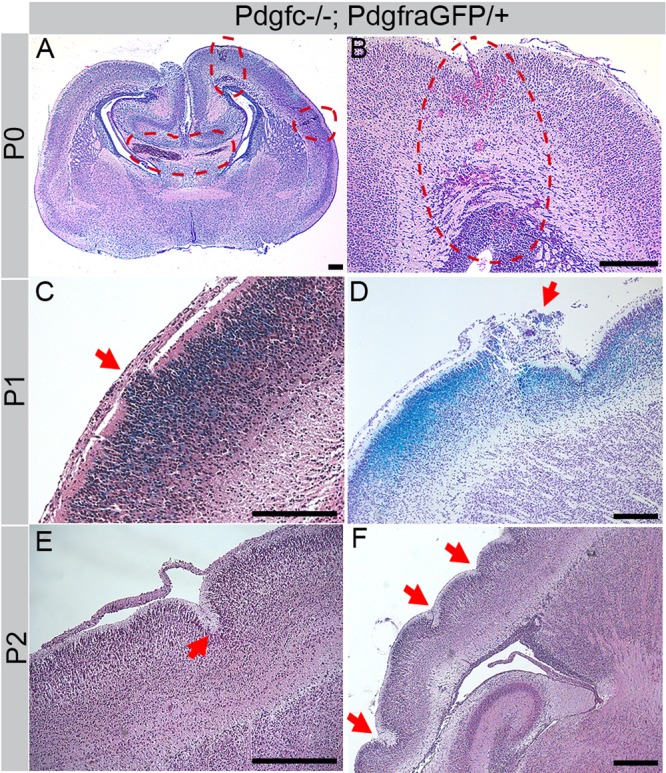
Cerebral abnormalities in cortex of Pdgfc−/−; PdgfraGFP/+ mice. Hematoxylin/eosin stained paraffin sections of mutant brains. (A) Coronal section at P0. Red dotted circles indicates areas of bleedings. (B) Coronal section, consecutive to previous image. Red dotted circle indicate bleedings all the way from the pial surface to the lateral ventricle. (C) Displaced cells (arrow) invade the marginal zone. Sagittal section of X-gal stained (blue) P1 brain. (D) Cresyl Violet stain at P1, sagittal section. Blue X-gal staining in cortical layer mark cells that normally express Pdgfc. Arrow indicates severely affected area. (E) Sagittal section at P2, arrow points at an invagination in the cortex. (F) Sagittal view of a wavy cortex at P2, arrows mark invaginations. Scale bars: 200 µm.